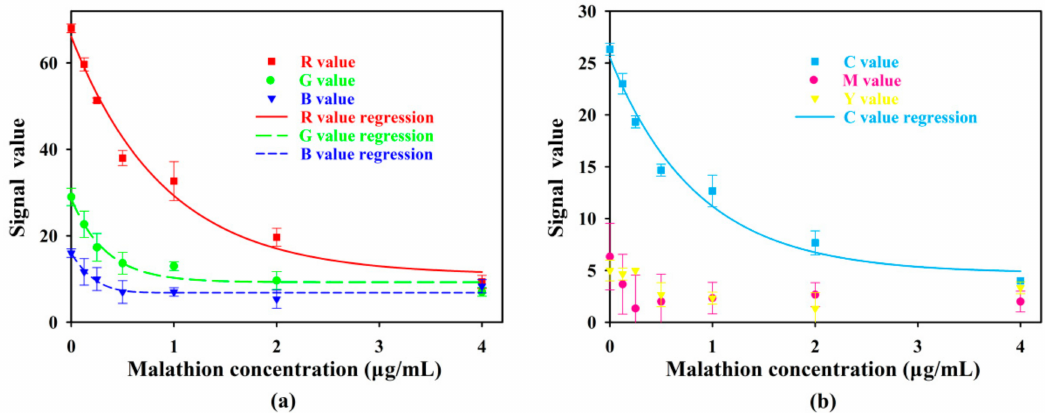
Figure 9. ( a ) Signal values in R, G, and B channels for different levels of malathion concentration. ( b ) Signal values in C, M, and Y channels for different levels of malathion concentration.